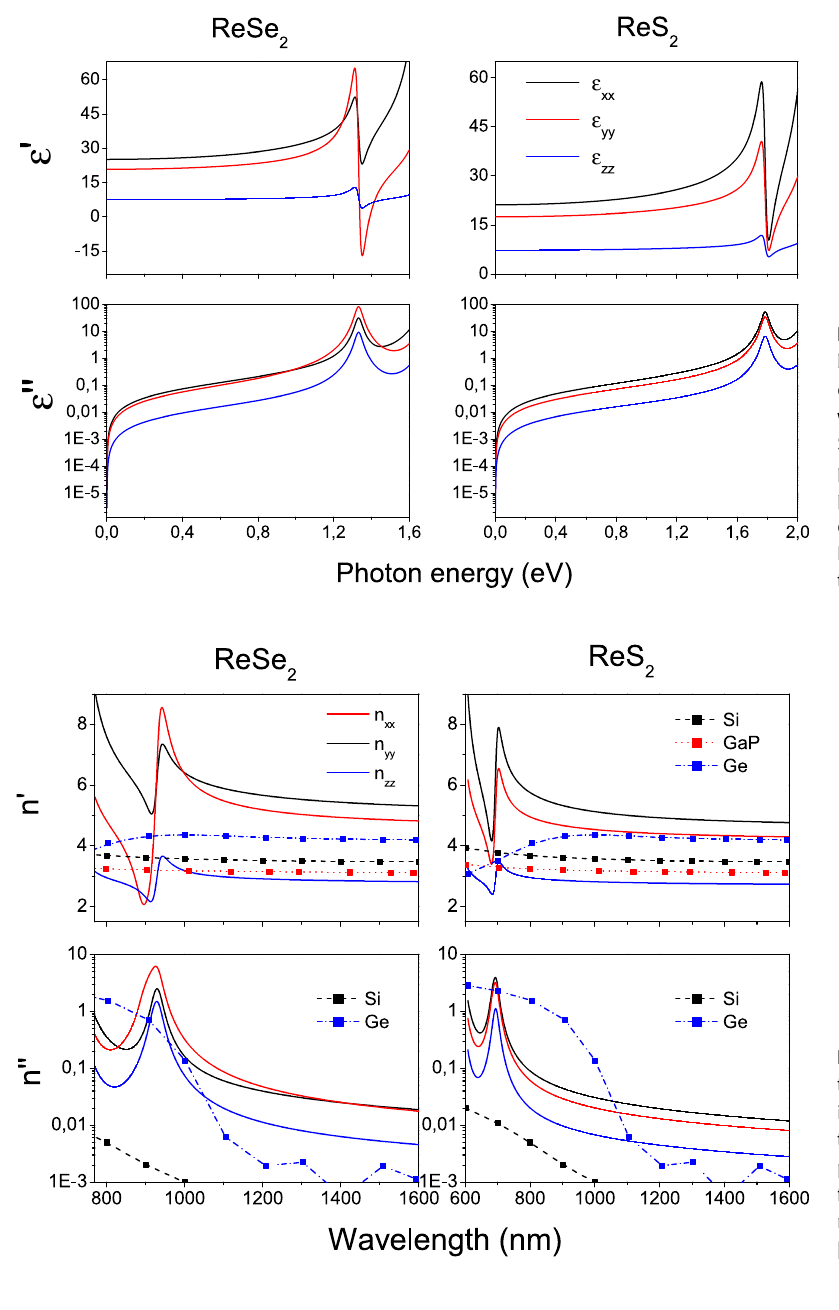
Figure 4: The calculated dependence of the the real and imaginary parts of refractive indexes of ReSe 2 (left) and ReS 2 (right) on the wavelength for different cases of light polarizations.Theknownexperimentaldata for the modern state-of-the-art high-index materials suchas c-Si [24], GaP [25],and Ge [26] are shown for